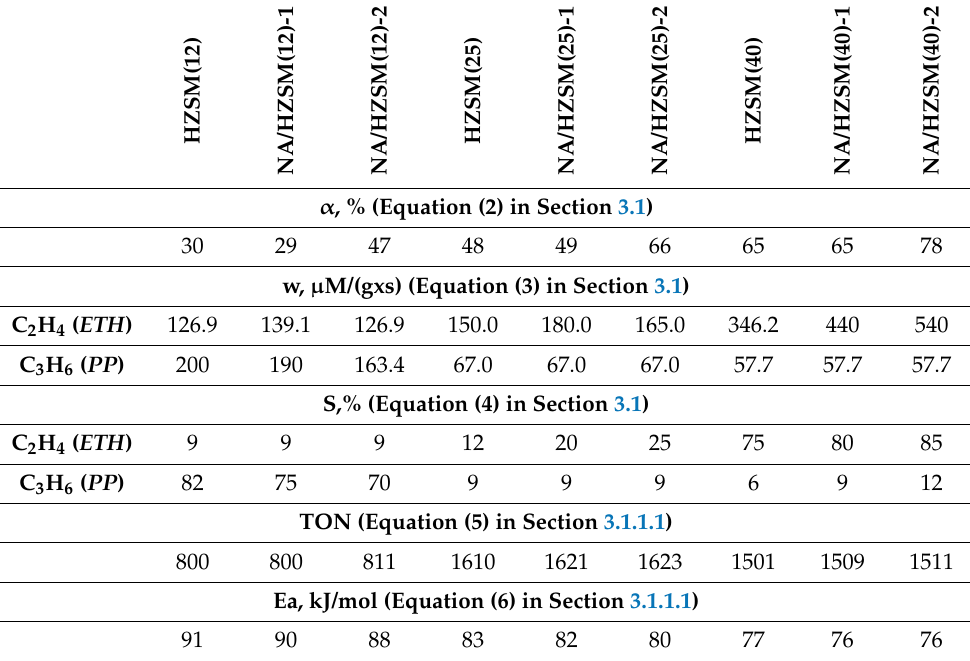
Table 8. Optimal propane cracking reaction performance (T = 923 K) (data from